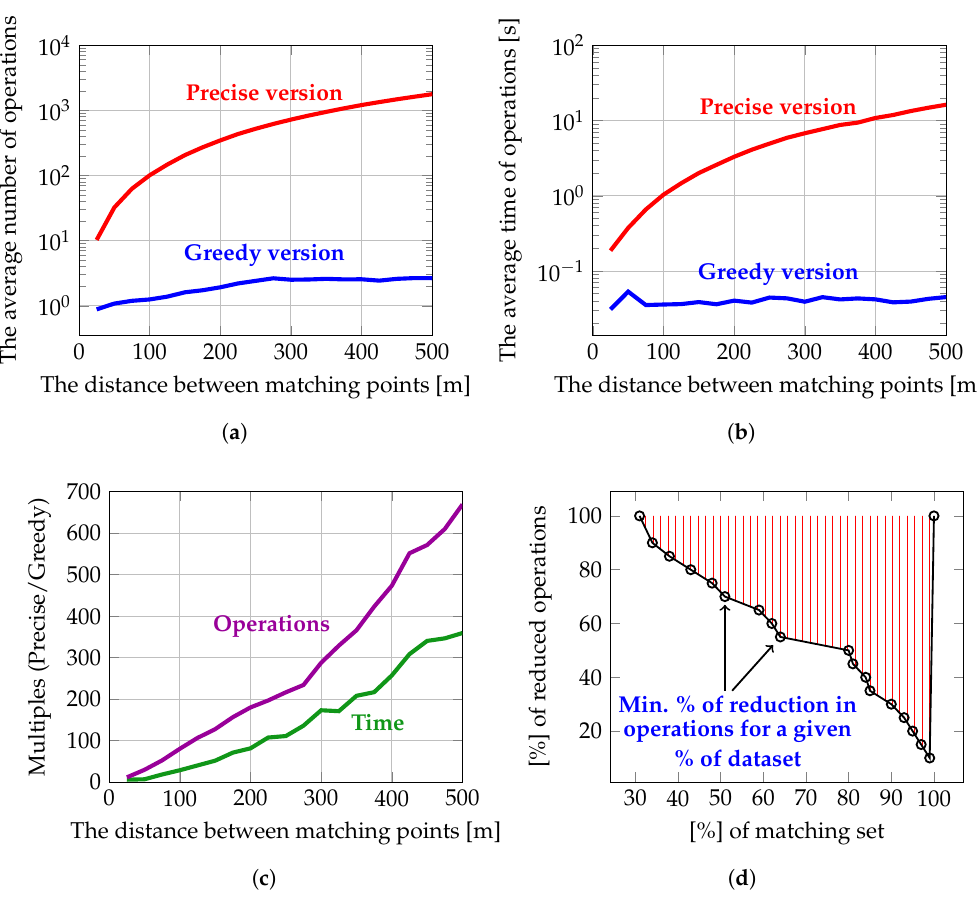
Figure 19. The average number of operations to be performed by the precise and greedy algorithm versions as a function of matching point distance ( a ); the average time of operations performed by the precise and greedy algorithm versions as a function of matching point distance ( b ); the ratios of the number of operations and time ( c ); and the minimum percentage of reduced operations for the given percentage of POIs in the validation set ( d